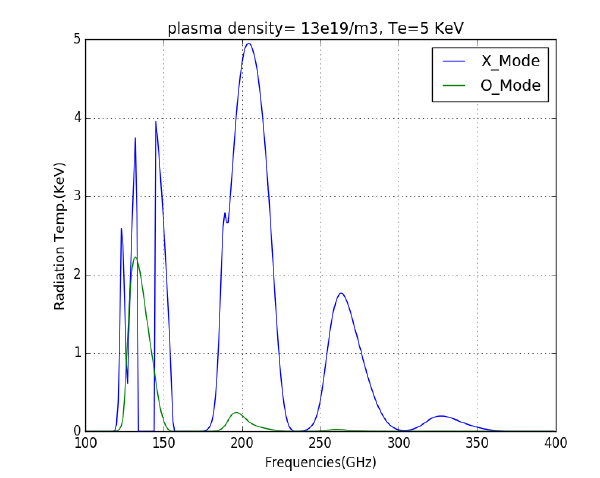
FIG. 1. Higher harmonics of ECE calculated from TRAVIS with parabolic electron temperature and plasma density profiles as input parameters 3 Multimode Notch Filter